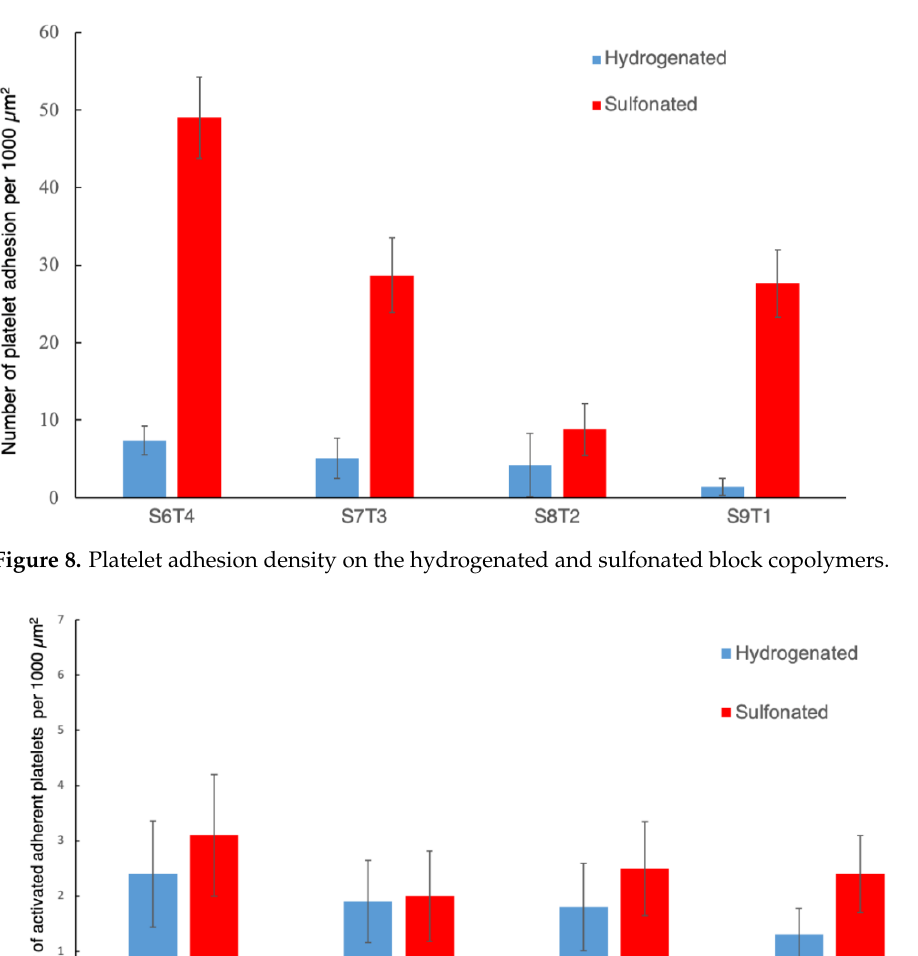
Figure 7. SEM micrographs (3000×) for the platelets adhered onto the hydrogenated ( a ) S6T4, ( c ) S7T3, ( e ) S8T2, ( g ) S9T1 and sulfonated hydrogenated ( b ) sS6T4, ( d ) sS7T3, ( f ) sS8T2, and ( h ) sS9T1 (scale bar: 1 µm).